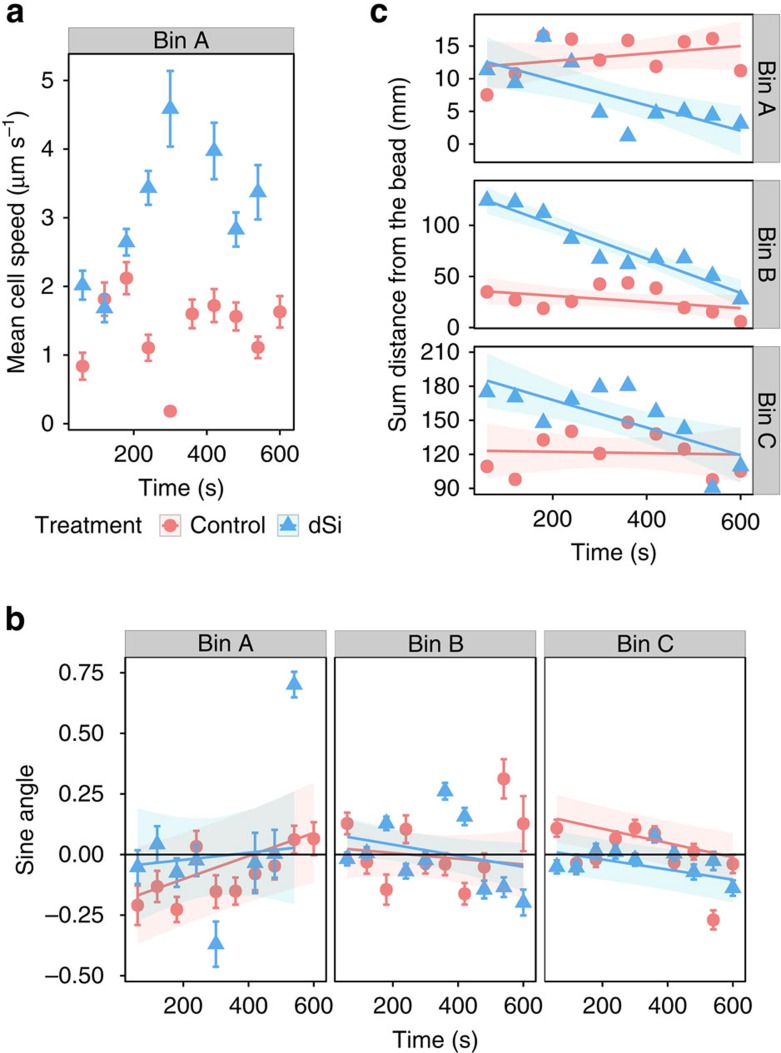
Analysis of track data from dSi and control movies.(a) Cell speed increases in bin A (blue triangles) under the influence of the steep dSi gradient. The log+1-transformed mean speed of cells was fitted using generalized additive mixed modelling (GAMM) for each bin. Cells move faster as they approach the bead in bin A (GAMM, n(dSi)=12, n(Control)=7, p(Si)=8.27−8, p(control)=0.176). (b) Plot of mean sine angle every 60 s, with overlaid shared area showing LME model fit with s.e.m. Non-directional movement of cells is observed as dSi had no effect on the angular orientation (LME, n(dSi)=34, n(Control)=28, P>0.05). (c) Plot of the sum distance of each cell from the bead every 60 s, with overlaid shaded area showing linear model fit with s.e.m. The decreasing sum distance over time is indicative for the preferential migration of the starved cells towards the dSi-loaded beads in all bins (linear model, n(dSi)=34, n(Control)=28, P=<0.05).